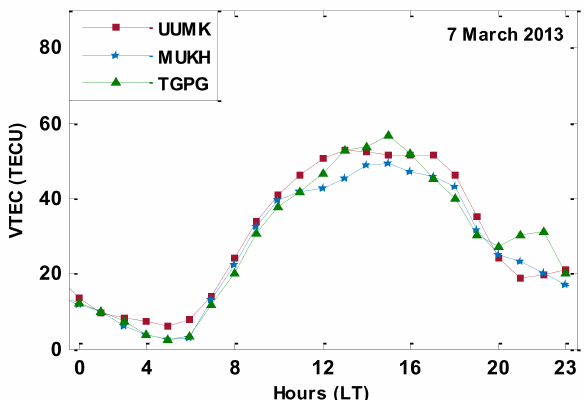
Figure 2. The diurnal hourly variation of the measured VTEC over UUMK, MUKH, and TGPG